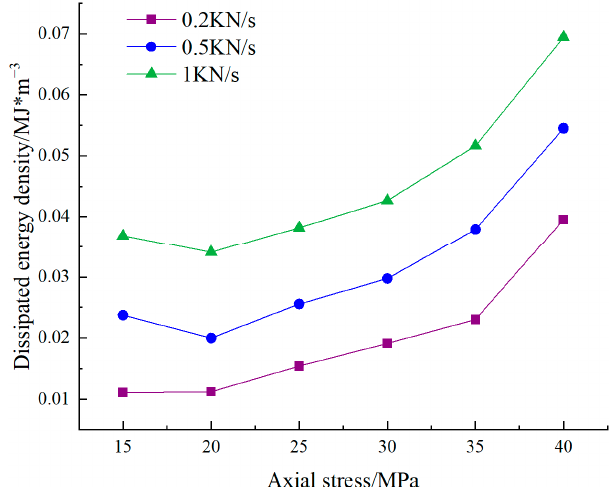
Figure 9. Dissipation energy density change curve.